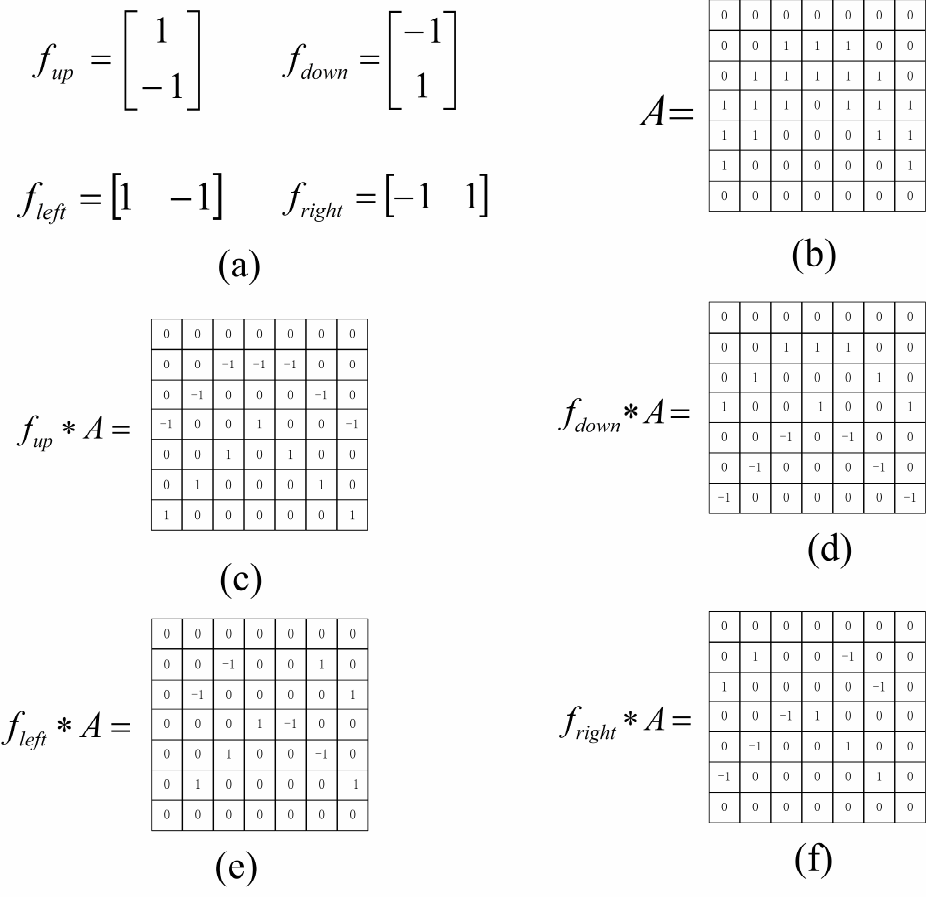
Figure 4. Four simple difference descriptors and an example for image gradient calculation. ( a ) Four pre-defined descriptors. ( b ) An example image A shown by the pixel value. ( c ) Upward gradient of the image A . ( d ) Downward gradient of image A . ( e ) Left gradient of the image A . ( f ) Right gradient of the image A